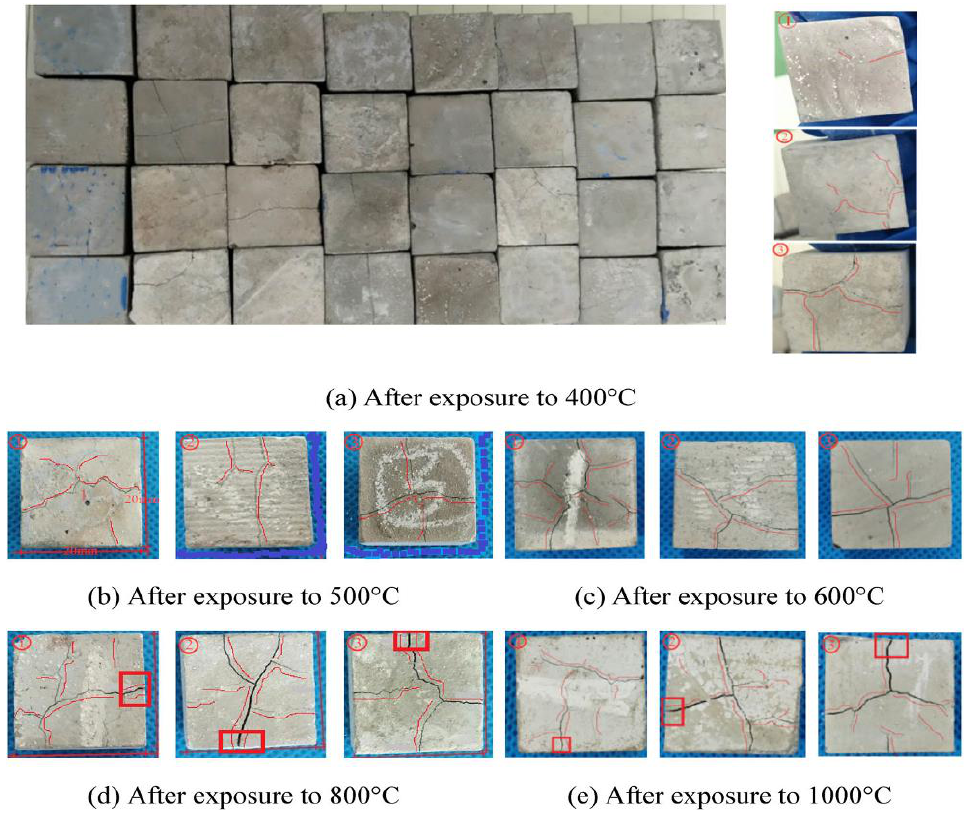
Figure 14. Exposed to different high-temperature environments [114]. ① Control samples, ② NS concrete samples, ③ MC concrete samples.